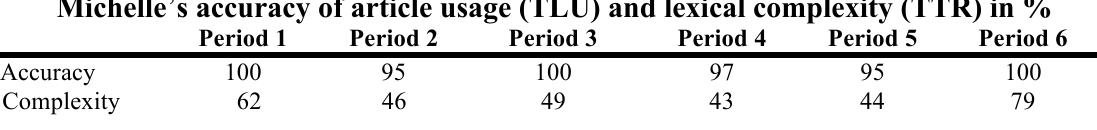
Michelle ’ s accuracy of article usage (TLU) and lexical complexity (TTR) in